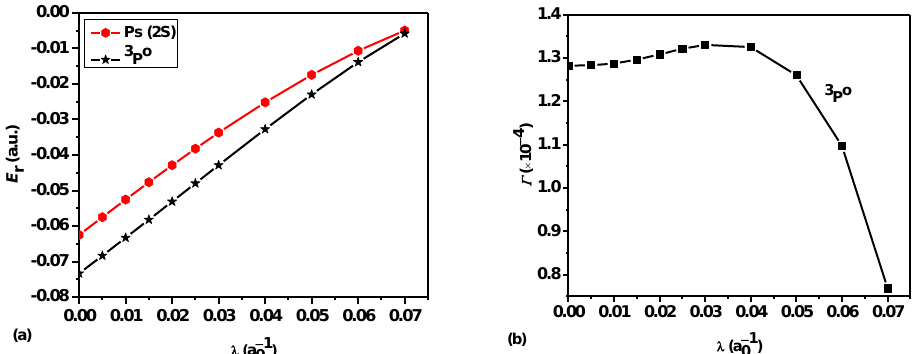
Figure 10. ( a ) Plot of the lowest 3 P o resonance energy E r of Ps − as a function of the screening parameter λ . ( b ) Plot of the resonance width Γ of Ps − as a function of the screening parameter λ .